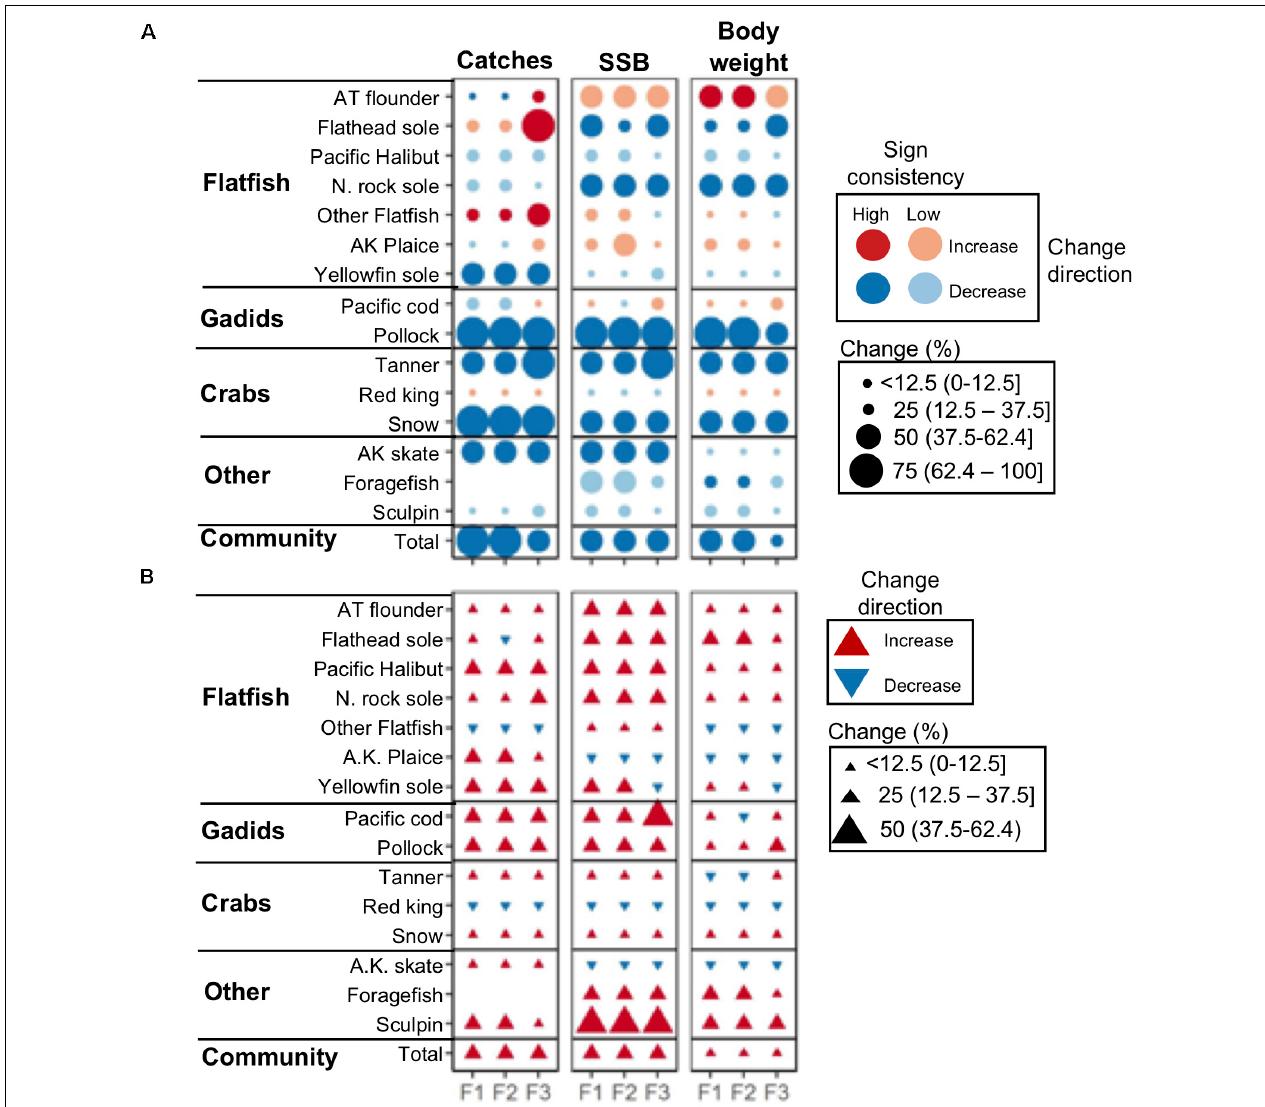
FIGURE 4 | (A) Projected percent change in catches, SSB, and body weight by 2090 (mean 2080–2100) relative to historical (mean 1995–2014) levels assuming a “business-as-usual” GHG emissions scenario (RCP 8.5) and three scenarios of TAC setting preferences by fisheries management: status quo (F1), gadid (F2), and flatfish (F3). Dark and light symbol colors denote ensemble projections with high ( ≥ 80%) and low ( < 80%) sign agreement, respectively. (B) Percent difference between 2090 ensemble projections under GHG mitigation scenario RCP 4.5 and RCP 8.5. Species names abbreviations: AT, arrowtooth; A.K., Alaska; N.,